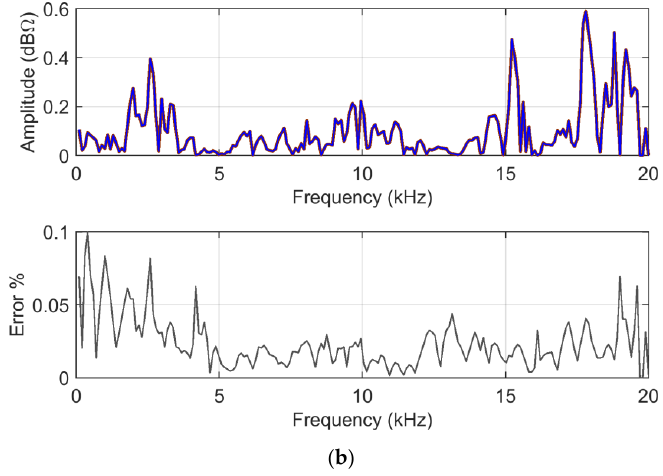
Figure 3. Z (45.0 km) and Z (45.5 km) input data in logarithmic scale: ( a ) ADM i and ( b ) FDM i plots as provided by analytical calculation (blue) and means of MCM output (brown); blue and brown curves are overlapped with underlying brown curve visible at the edges of the blue one. The relative error remains below 0.15% in all cases, demonstrating the reliability of MCM simulations and lack of biasing. It may be concluded thus that logarithmic compression has helped form a more balanced assessment of curve similarity and diversity.